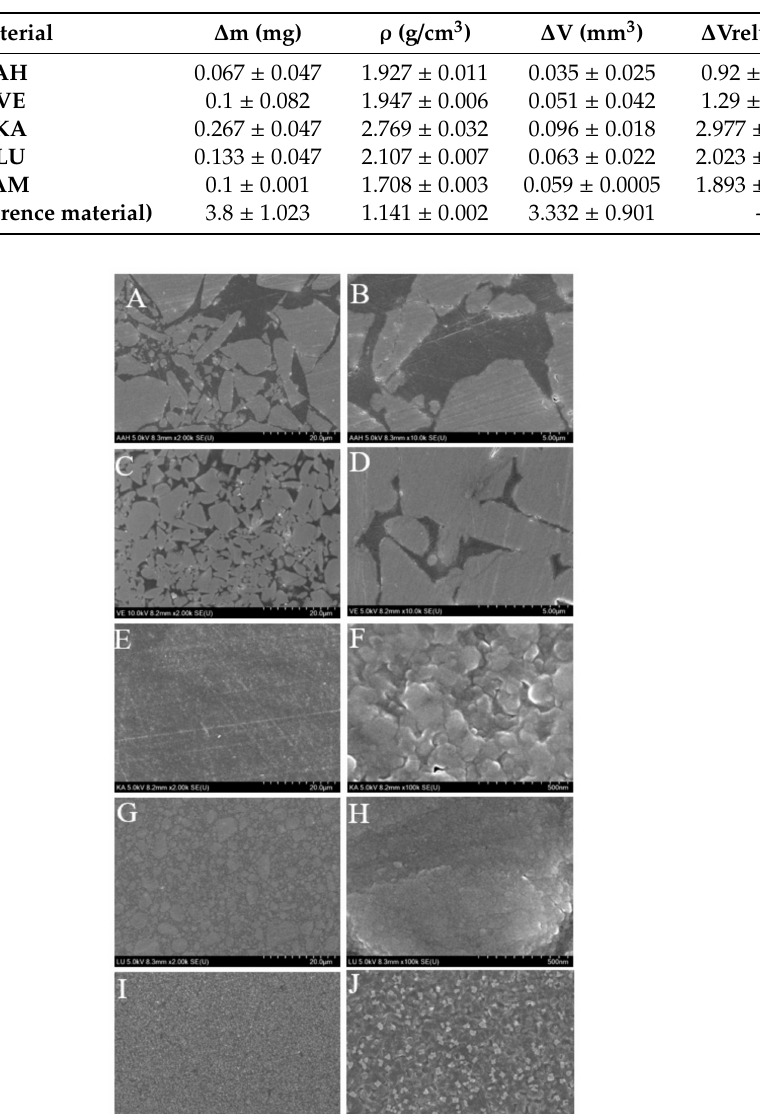
Table 2. Meanlossinmass, materialdensity, lossinvolume, andrelativewornvolumeaftertoothbrushing.